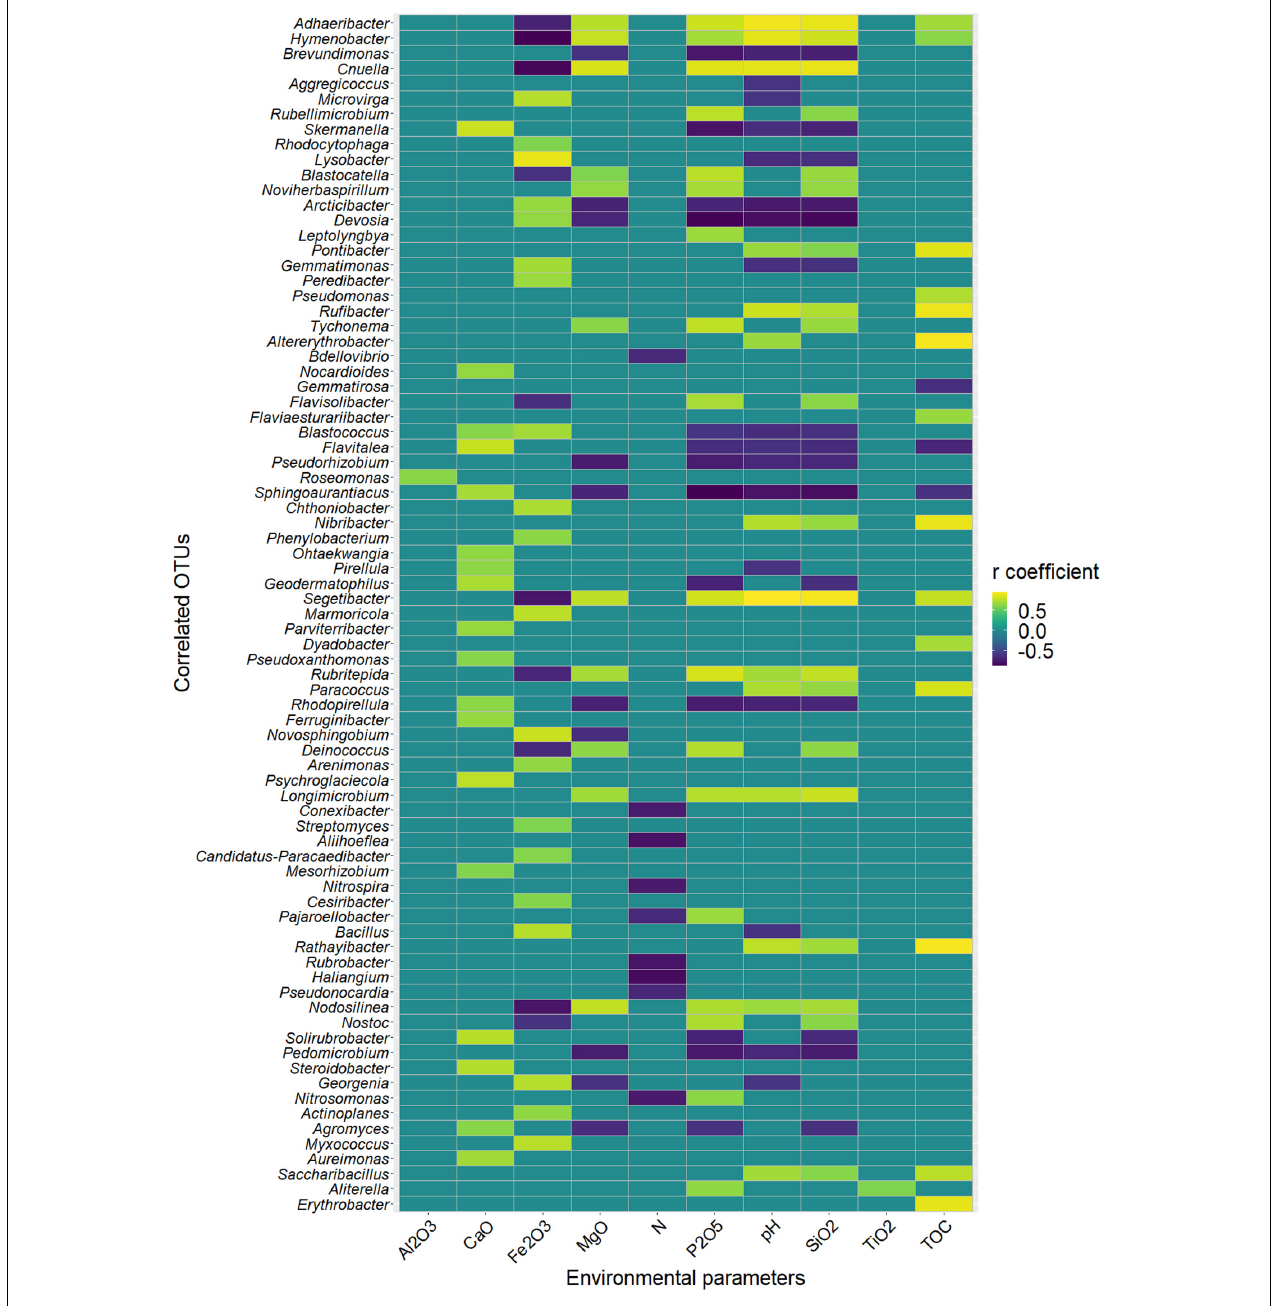
FIGURE 4 | Heatmap of the statistically significant coefficients of Pearson’s correlations (false discovery rate (fdr) corrected; p < 0.05) between the relative abundance of taxa and concentrations of environmental parameters across all sites. Only threshold higher than 0.7 was